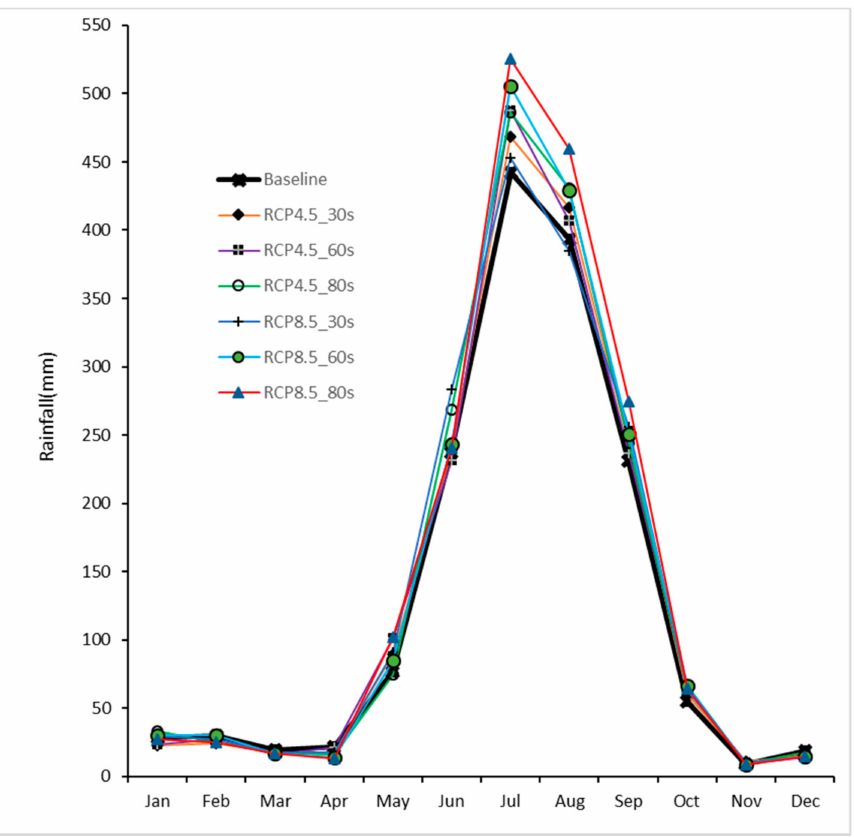
Figure 5. Comparison of monthly rainfall between observed (1975–2005) and projected climate using the ensemble of three